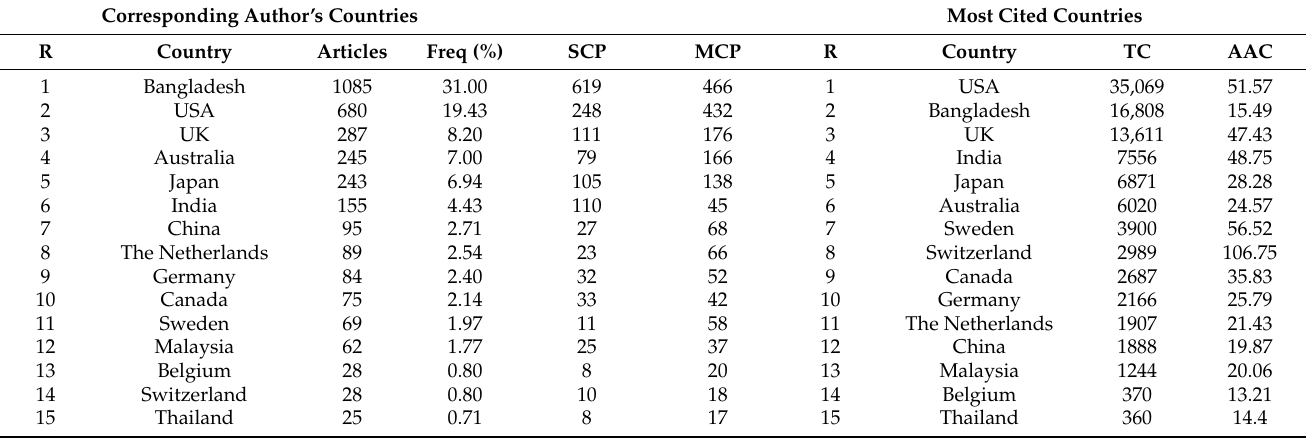
Table 4. Top 15 productive countries concerning Bangladesh water-research-related publications (R is the rank based on the number of articles. SCP and MCP refer to single- and multiple-country publications, respectively. AAC is the average article